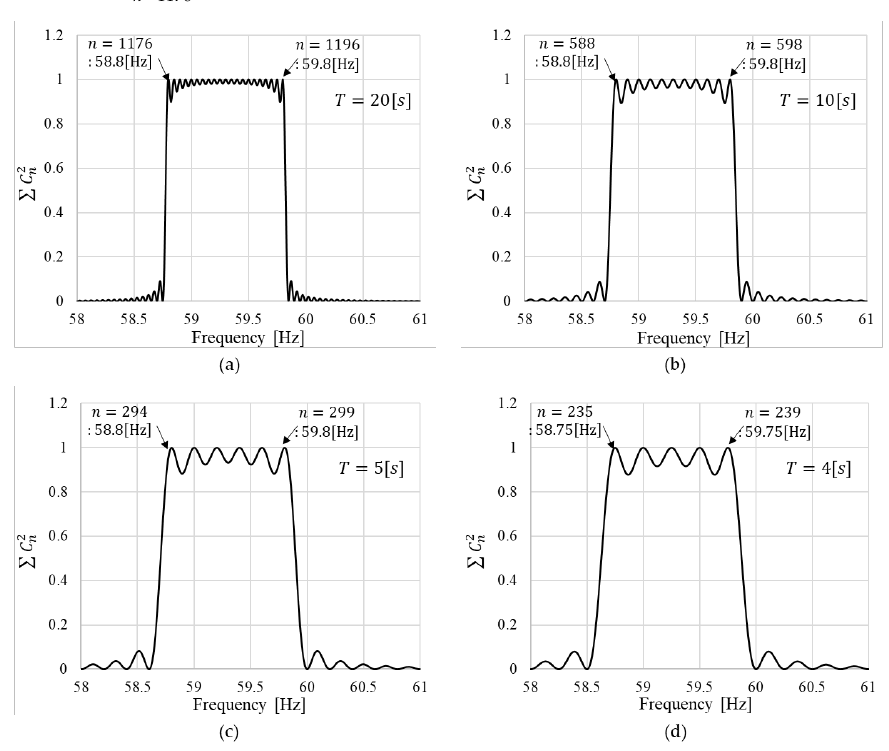
Figure 6. Plots of ∑|𝐶 𝑛 | 2 versus the frequency when ( a ) 𝑇 = 20 s, ( b ) 𝑇 = 10 s, ( c ) 𝑇 = 5 s, and ( d ) 𝑇 = 4 s. ( d ) T = 4